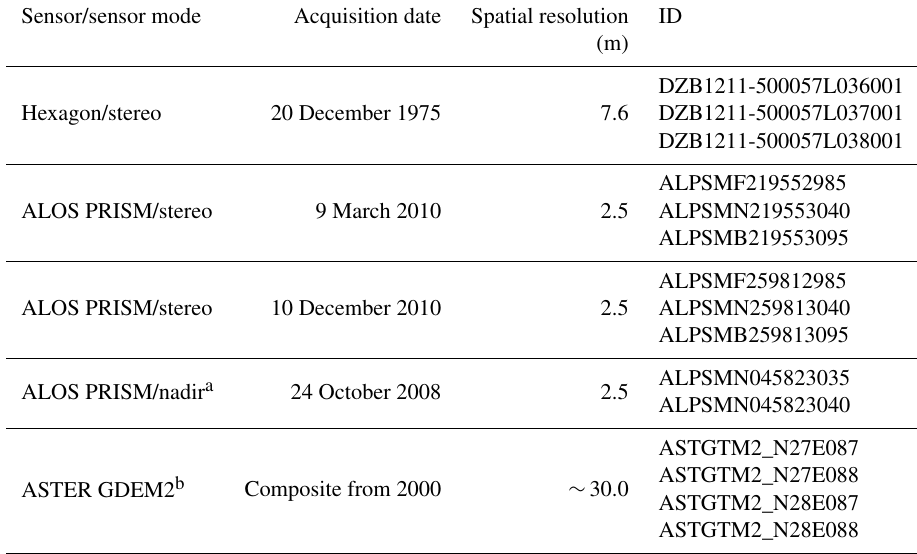
Table 1. Details of remote sensing data used in this study to generate the digital elevation models (DEMs), map debris-covered and debris-free glacier surfaces and supraglacial ponds, and compute the surface ice-flow velocity field and